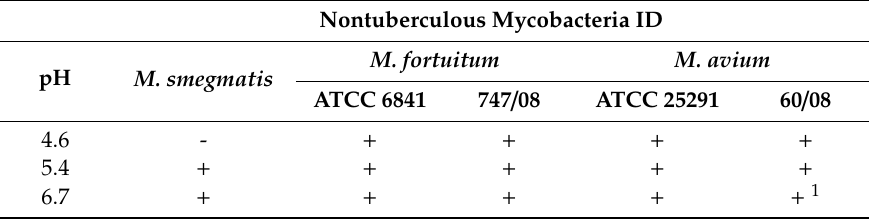
Table 1. NTM persistence in vitro at di ff erent